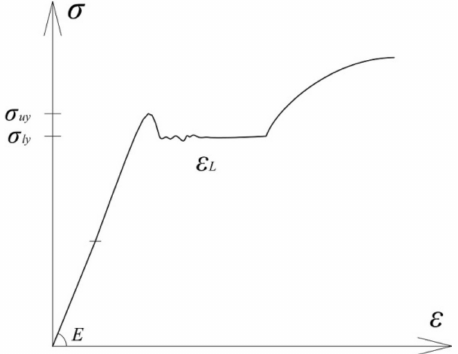
Figure 2. The Lüders band phenomenon occurring under monotonous loading of mild